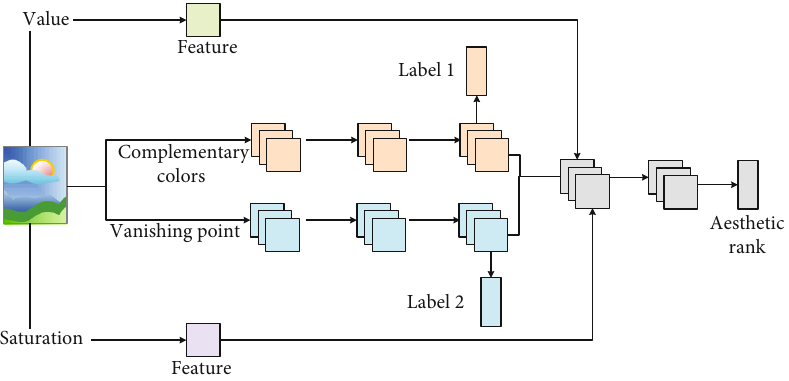
Figure 2: Frame diagram of the image aesthetic evaluation method based on global perception.